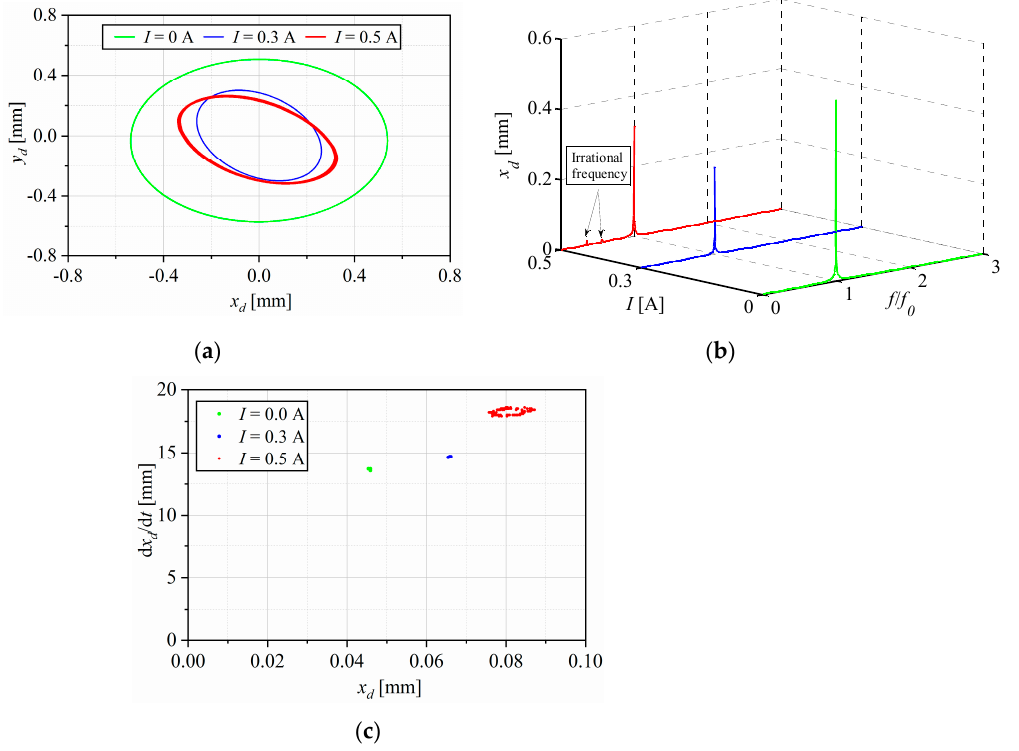
Figure 13. Dynamic responses of the rotor system under several currents. ( a ) Orbit at critical speed, ( b ) spectrogram at critical speed and ( c ) Poincaré map at critical speed.